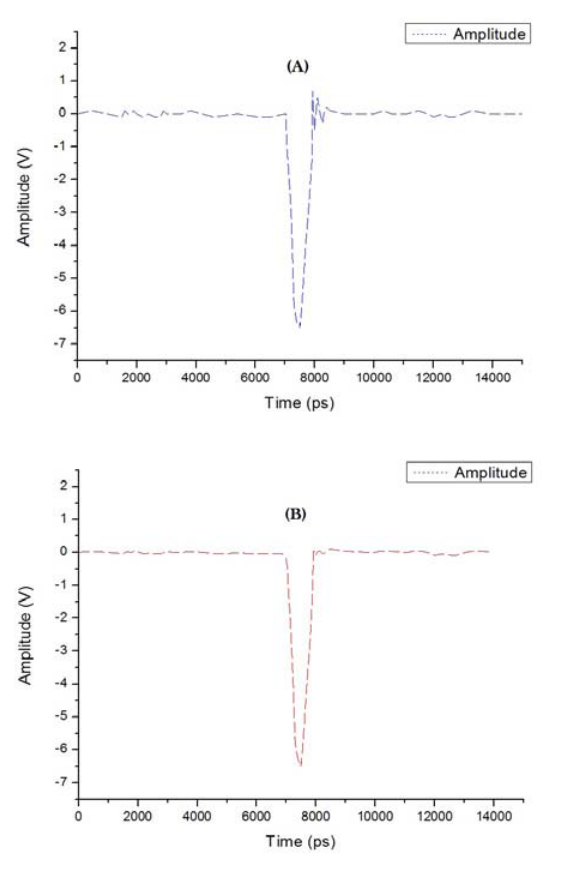
Figure 8: Output waveform before (A) and after (B) the application of new model of SRD respectivily.